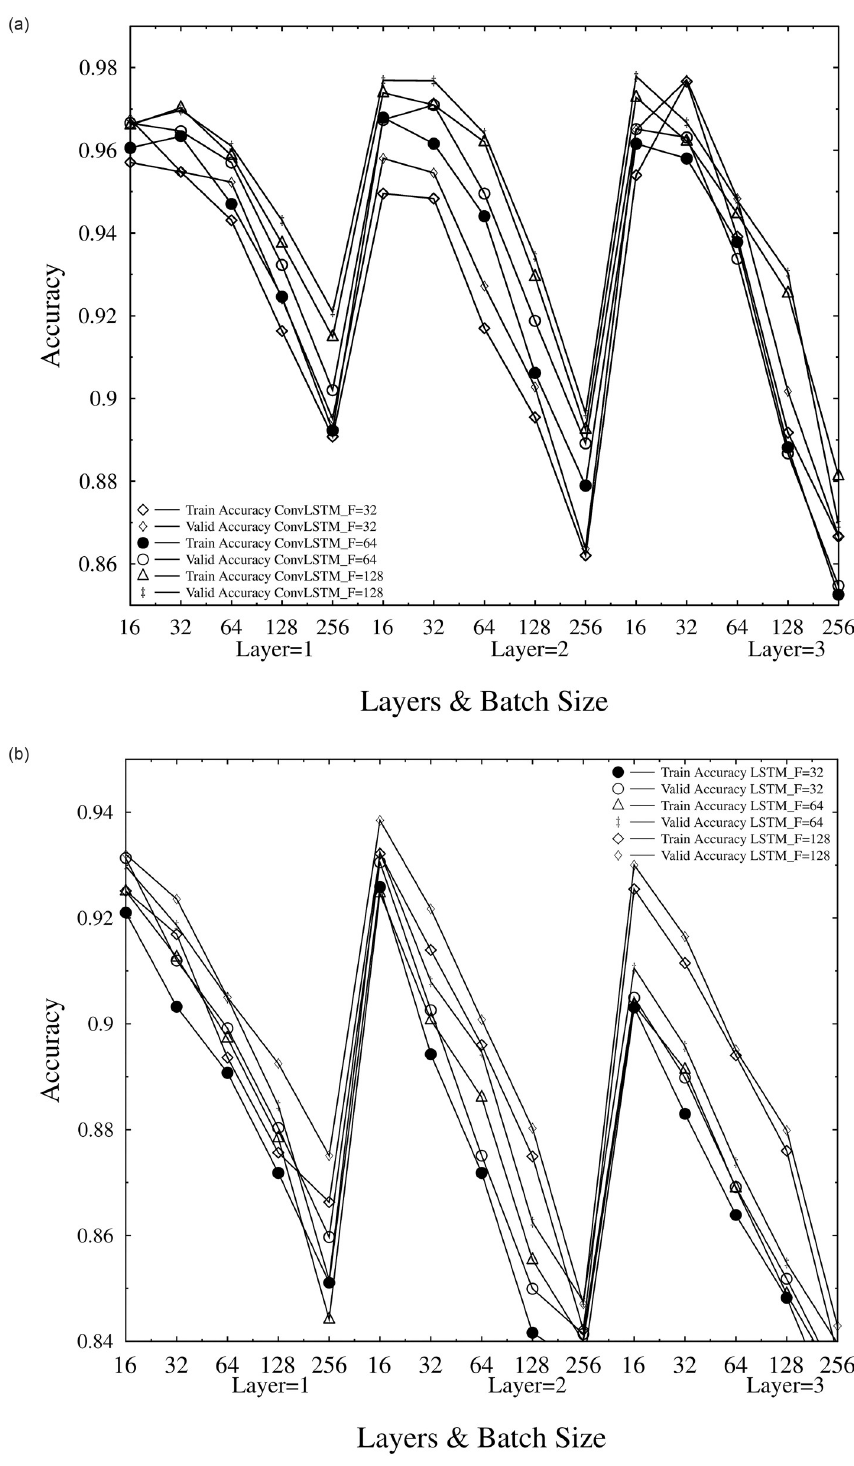
Fig 9. (a). Experimentation results plot of ConvLSTM (b). Experimentation results plot of LSTM.